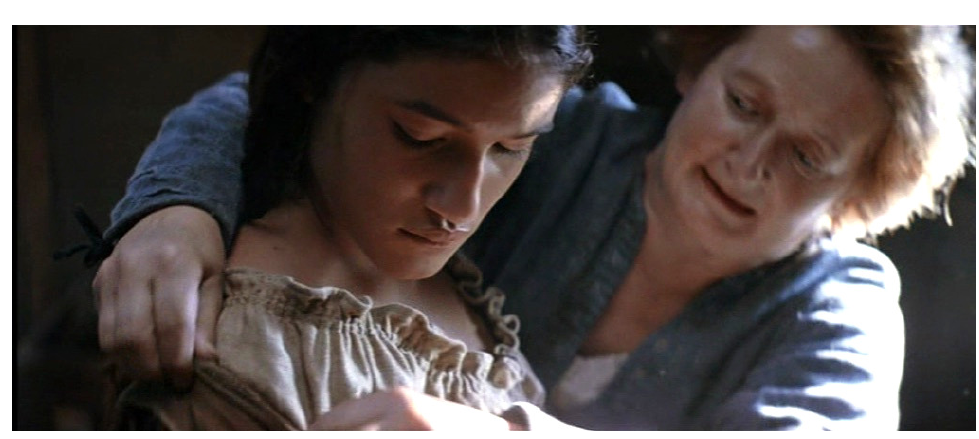
Figure 17: Pocahontas is dressed (cf. Smith’s grooming in Figure 14); the framing emphasising the co-existence of the strange and the